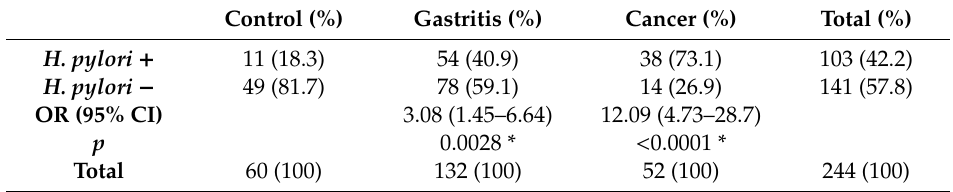
Figure 1. Two percent agarose gel stained with ethidium bromide showing H. pylori PCR products (150 bp) used to identify H. pylori in gastric biopsy samples from patients with normal gastric mucosa (1 to 3), gastritis (4 to 7), and gastric cancer (8 to 11). Water was used as negative control; as positive control, H. pylori DNA from culture was used. The band of approximately 1200 bp is a non-specific band, not associated with H. pylori. Table 2. H. pylori detected in the Control, Gastritis, and Cancer